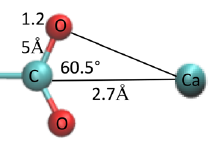
Figure 6. The geometric diagram of Ca 2+ closed to the carboxyl group of